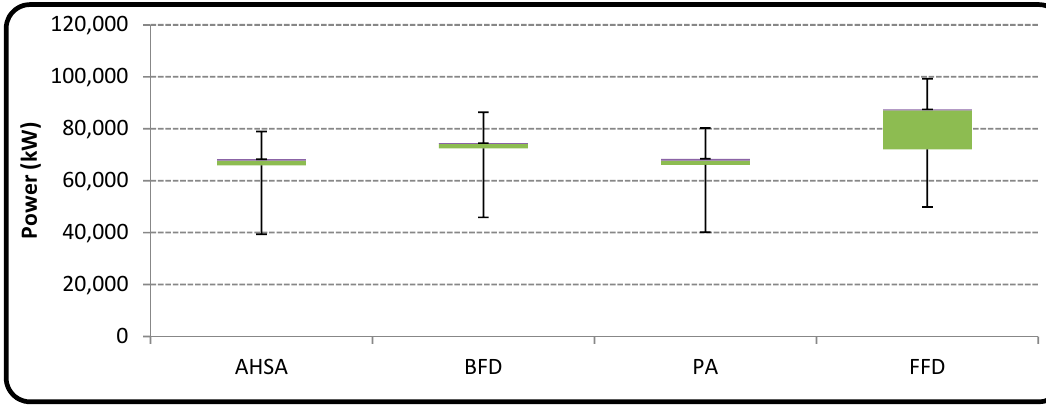
Figure 12. Impact of migration ( a ) Number of migrations ( b ) RVA% ( c ) Power consumption.